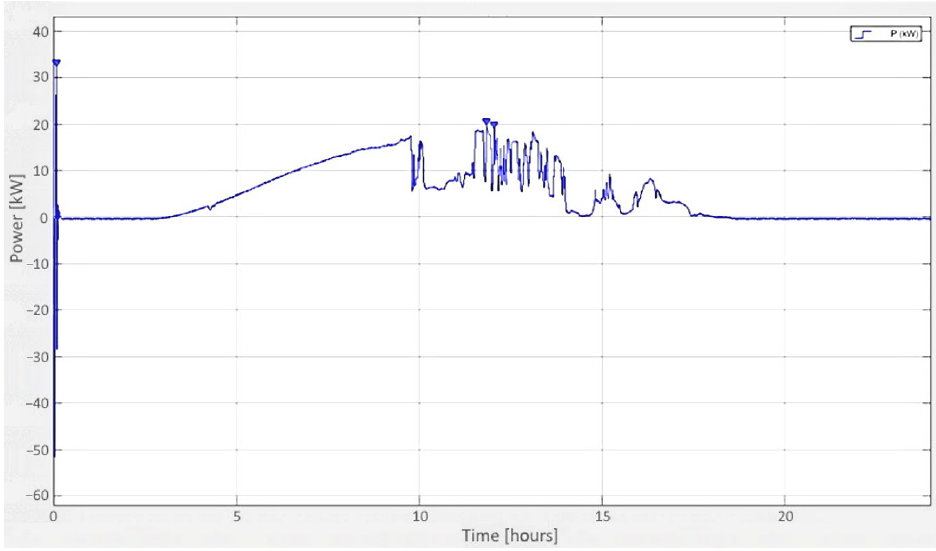
Energies 2023 , 16 , x FOR PEER REVIEW Figure 24. Daily waveform of the power supplied (19.825 kW) to the network on a sample day in July.